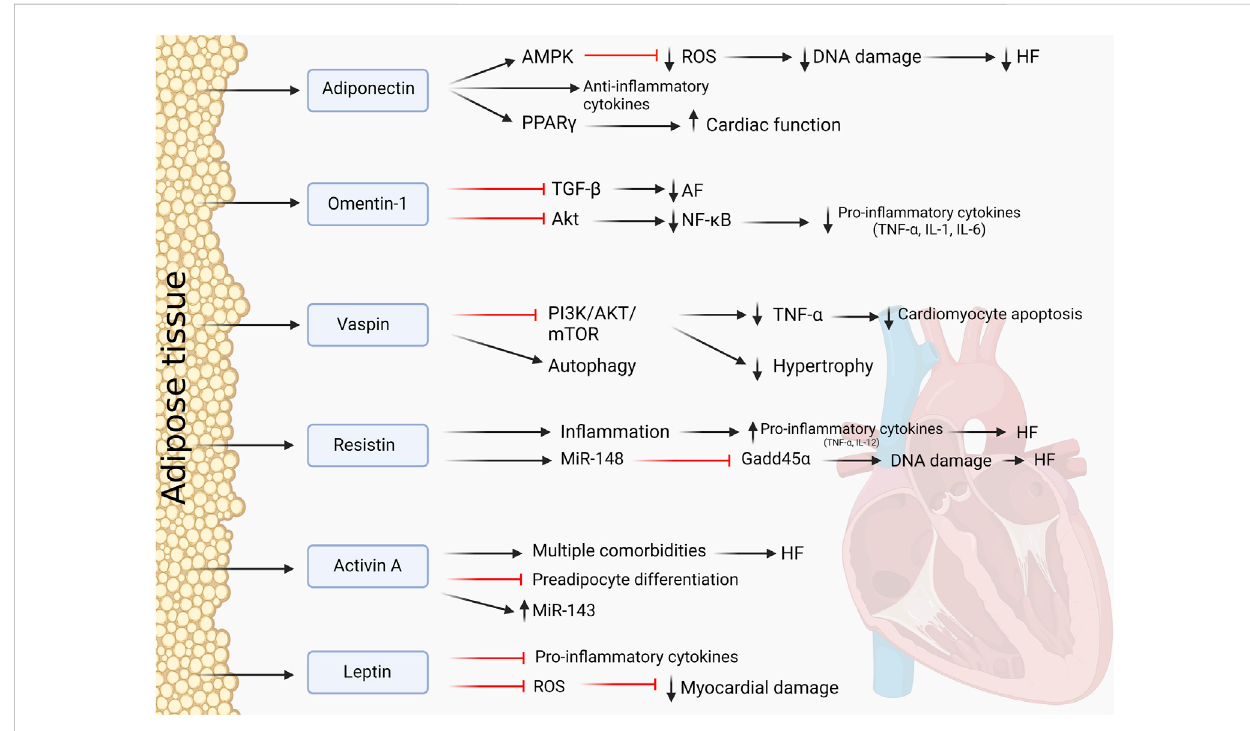
Adipokines and their in fl uence on the heart. Protective and pathological effects of AT-derived adipokines on the cardiac